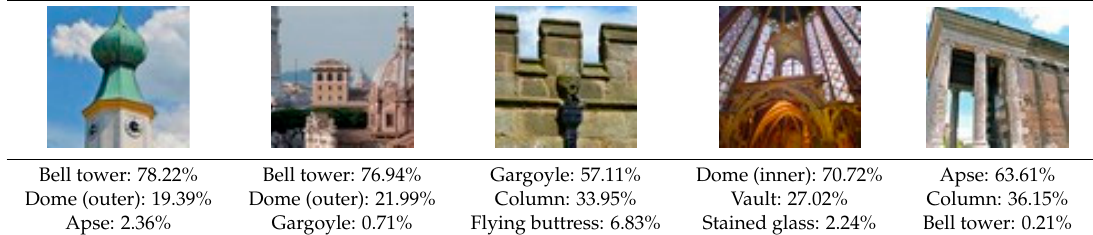
Bell tower: 78.22%